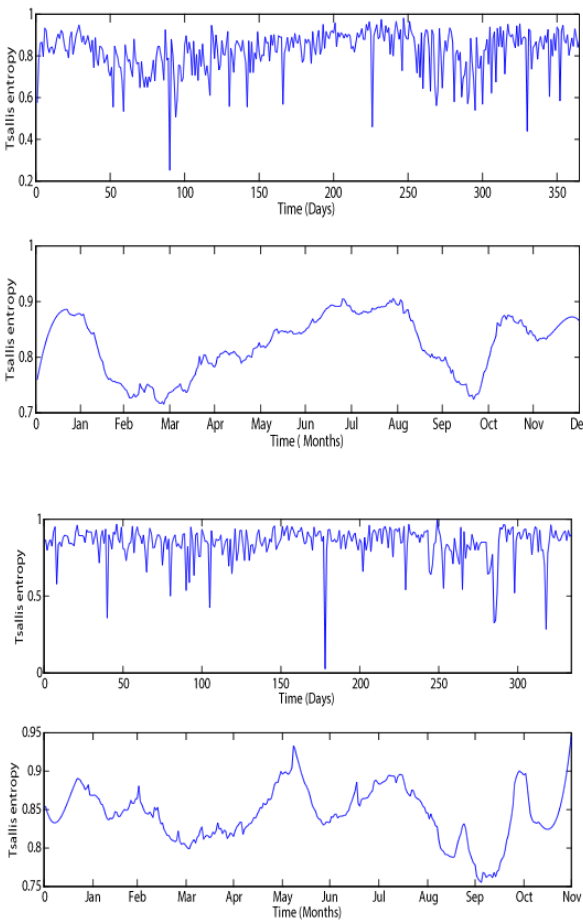
Figure 13. (a) Daily variation of Tsallis entropy for TEC measured at the Enugu station for the year 2011 showing the original data (upper panel) and the smoothed plot of daily variation of Lyapunov exponents for TEC measured at the Enugu station for the year 2011 (lower panel). (b) Daily variation of Tsallis entropy for TEC mea- sured at the Toro station for the year 2011 showing the original data (upper panel) and the smoothed plot of daily variation of Lyapunov exponents for TEC measured at the Enugu station for the year 2011 (lower